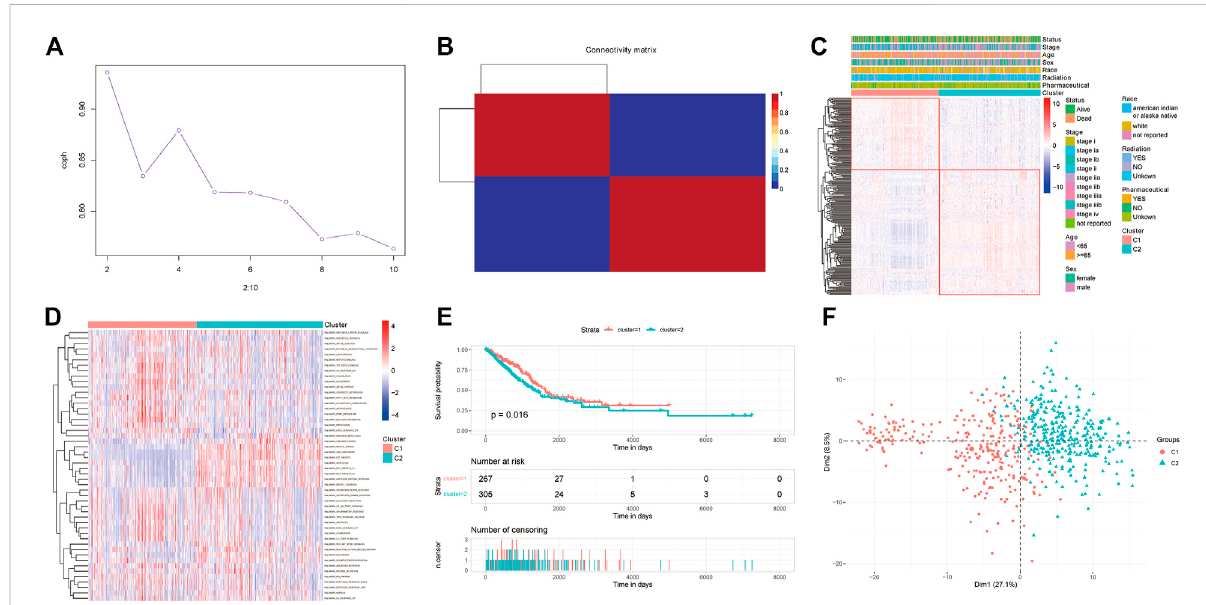
FIGURE 4 NMFclusteringresults. (A) NMFclustercophenetic versus numberofclusters. (B) NMFclusteringresults. (C) Heatmapofdifferentiallyexpressed platinum resistance genes associated with clinical information. (D) Heatmap of GSVA analysis of cancer hallmarks. (E) Survival differences for NMF clustering. (F) Plot of PCA results for NMF clustering